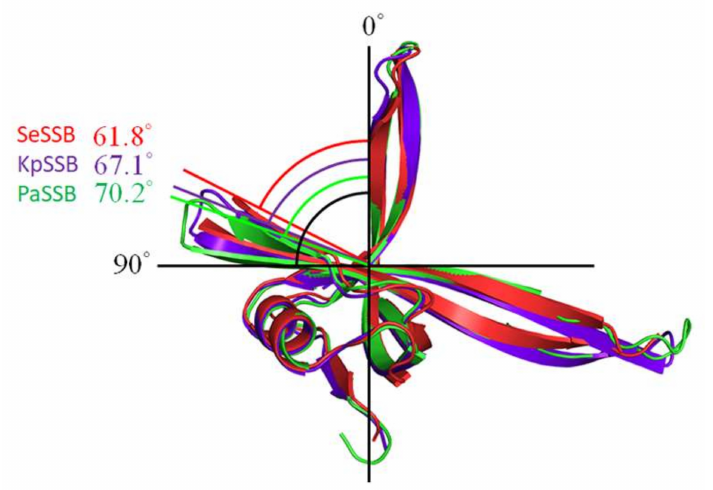
Figure 8. Structural differences among SeSSB, KpSSB, and PaSSB. The ssDNA interaction cavity of SSB is created by strands β 1 (cid:48) and β 4. The angles between strands β 1 (cid:48) and β 4 of the SeSSB, KpSSB, and PaSSB were 61.8 ◦ , 67.1 ◦ , and 70.2 ◦ , respectively. That is, the wider the groove of the OB fold, the bigger the binding-site size of the